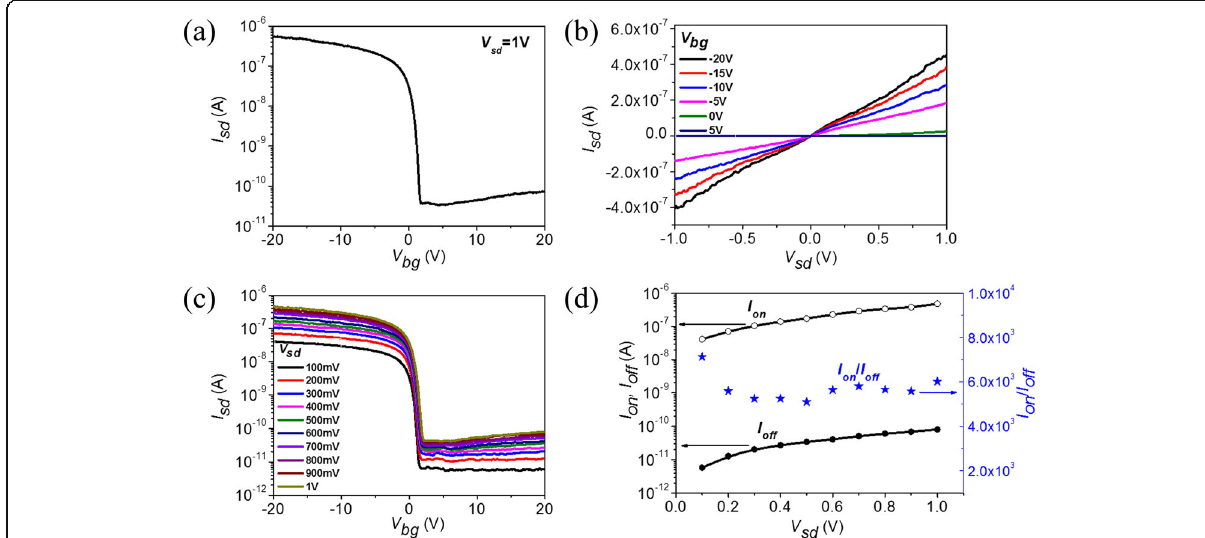
Fig. 2 Electric properties of multi-layered MoTe 2 transistor in air at RT. a Transfer characteristics of MoTe 2 transistor at V sd = 1 V in air. b Output characteristics of MoTe